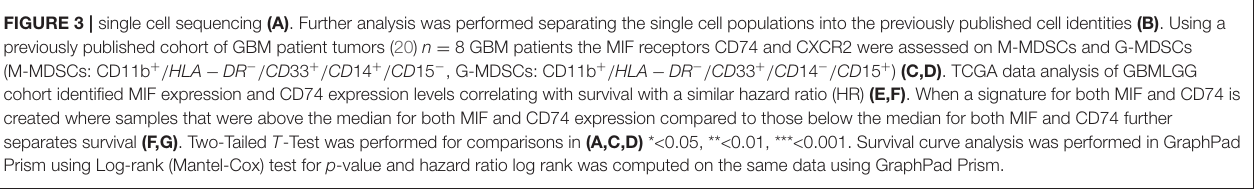
FIGURE 3 | single cell sequencing (A) . Further analysis was performed separating the single cell populations into the previously published cell identities (B) . Using a previously published cohort of GBM patient tumors (20) n = 8 GBM patients the MIF receptors CD74 and CXCR2 were assessed on M-MDSCs and